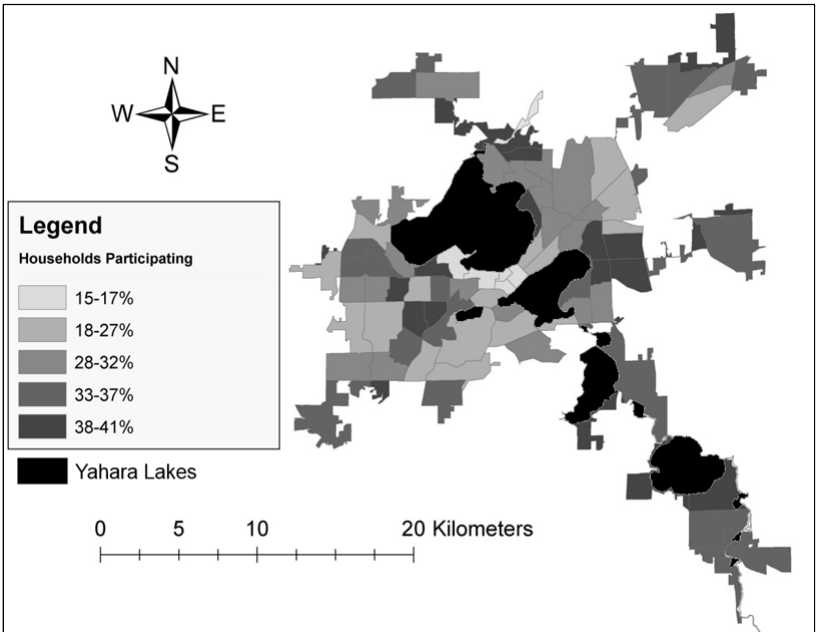
Figure 8. Percent of Homes Participating in Home Gardening by Census Tract Percent of households participating increases as distance from urban center and median household income